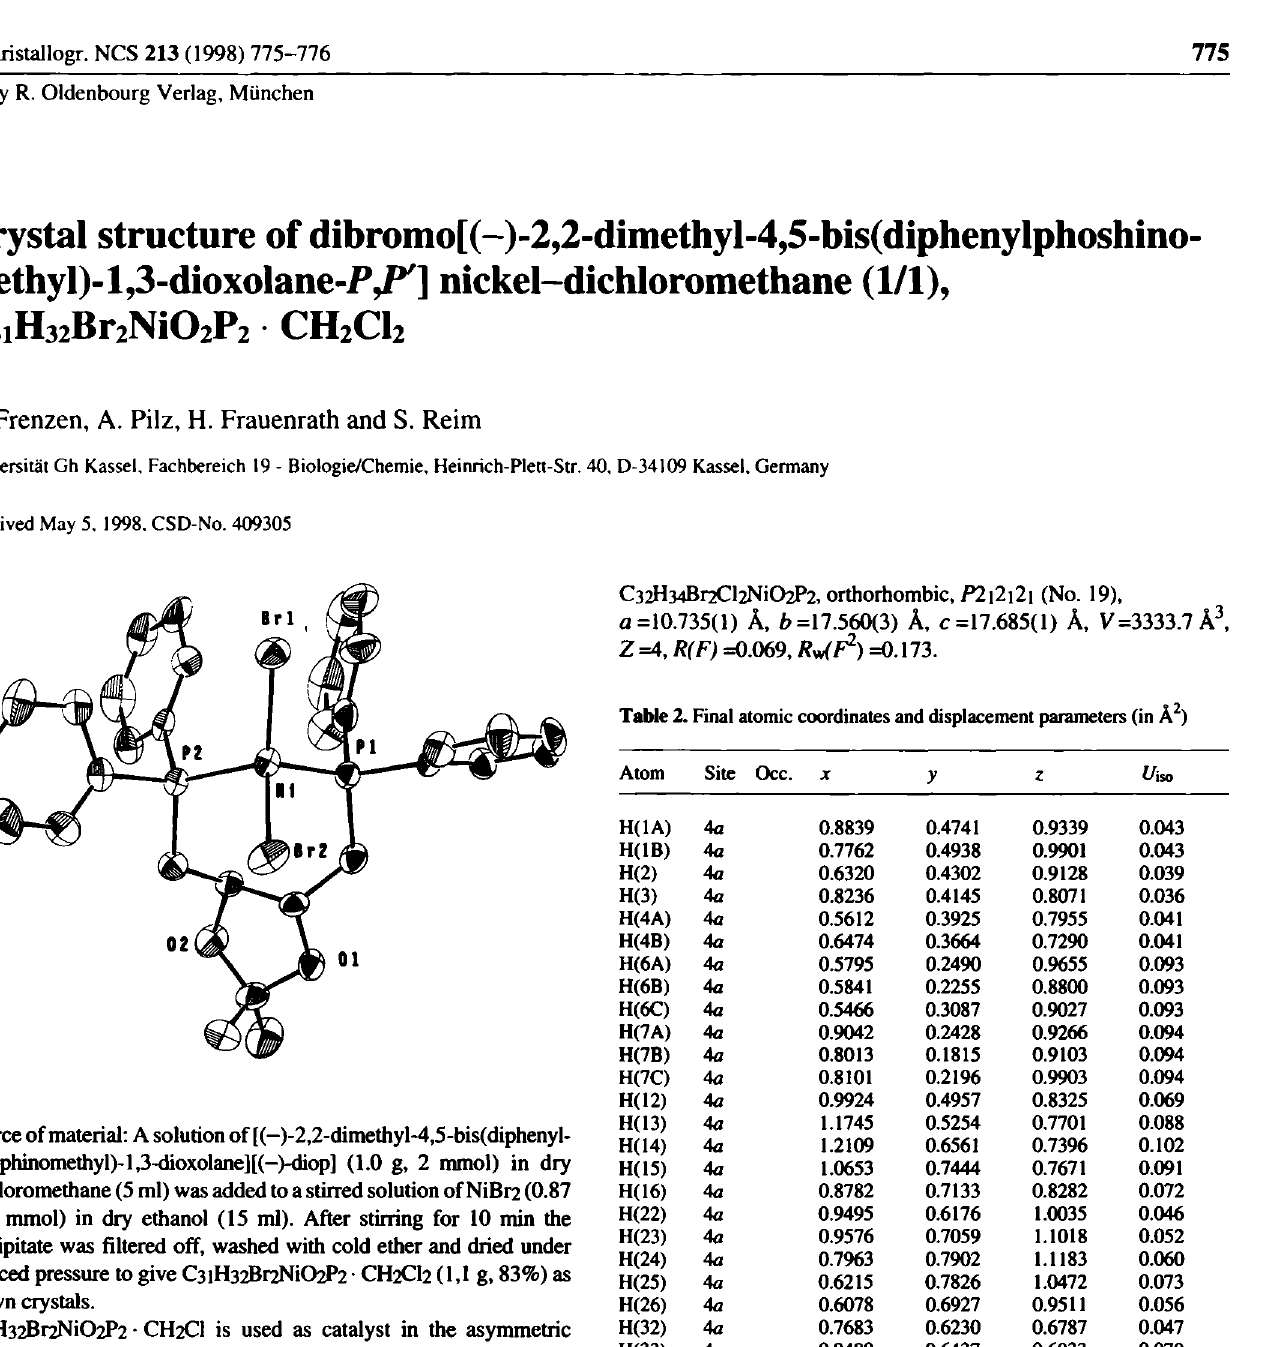
Table 1. Parameters used for the X-ray data collection Crystal: